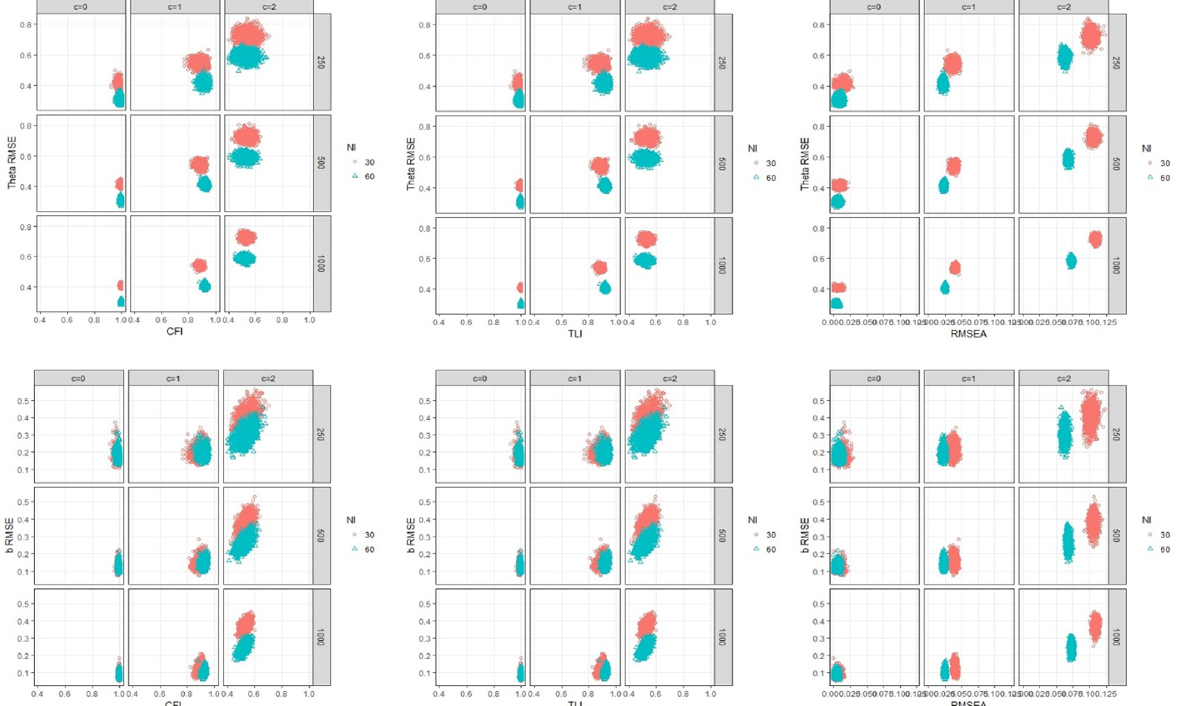
Fig 1. The relationship between WLSMV-based fit indices, theta RMSE/ ^ b RMSE, and test factors (TD).